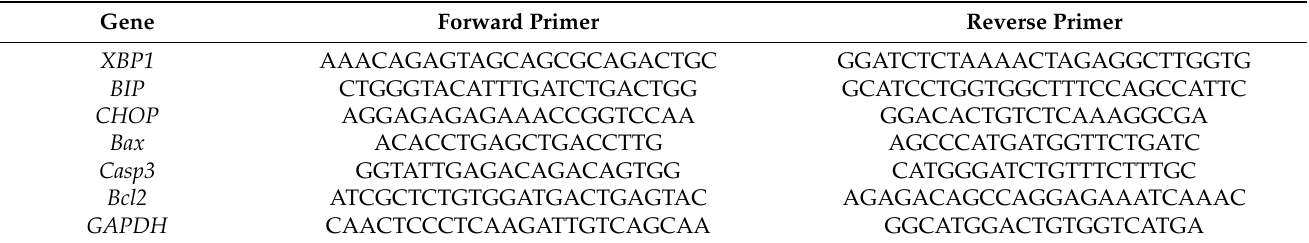
Table 1. Primers used for real-time